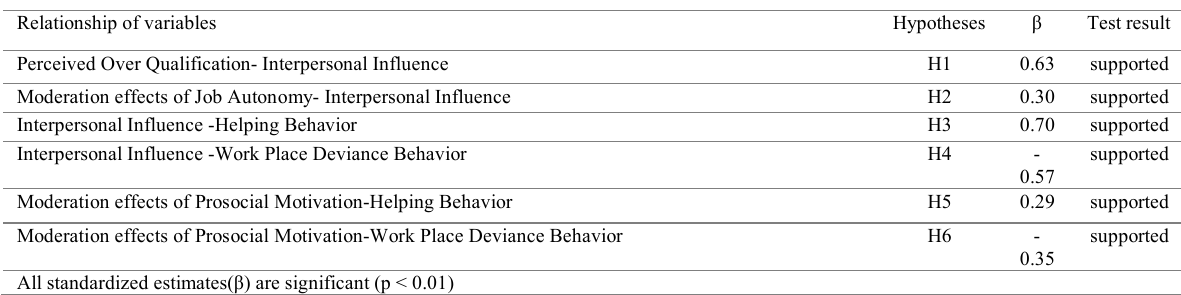
Table 3: Results of SEM